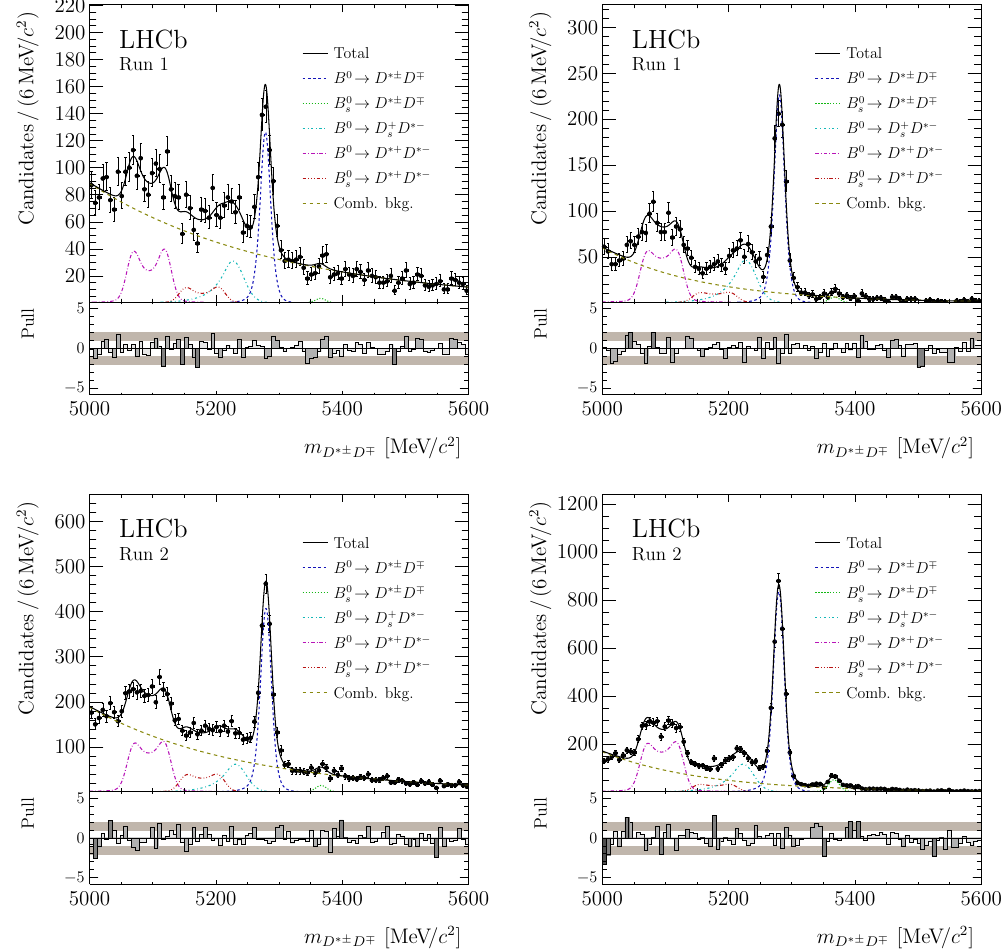
Figure 1 . Mass distributions for the B 0 D (cid:3)(cid:6) D (cid:7) decay with (left) D 0 K (cid:0) (cid:25) (cid:0) (cid:25) + (cid:25) + and (right) ! ! D 0 K (cid:0) (cid:25) + for (top) Run 1 and (bottom) Run 2 data samples. Besides the data points and the ! full PDF (solid black) the projections of the B 0 signal (dashed blue), the B 0 D (cid:3)(cid:6) D (cid:7) background s ! (dotted green), the B 0 D + D (cid:3)(cid:0) background (dash-dotted turquoise), the B 0 D (cid:3) + D (cid:3)(cid:0) back- s ! ! ground (long-dash-dotted magenta), the B 0 D (cid:3) + D (cid:3)(cid:0) background (dash-three-dotted red) and s ! the combinatorial background (long-dashed green) are